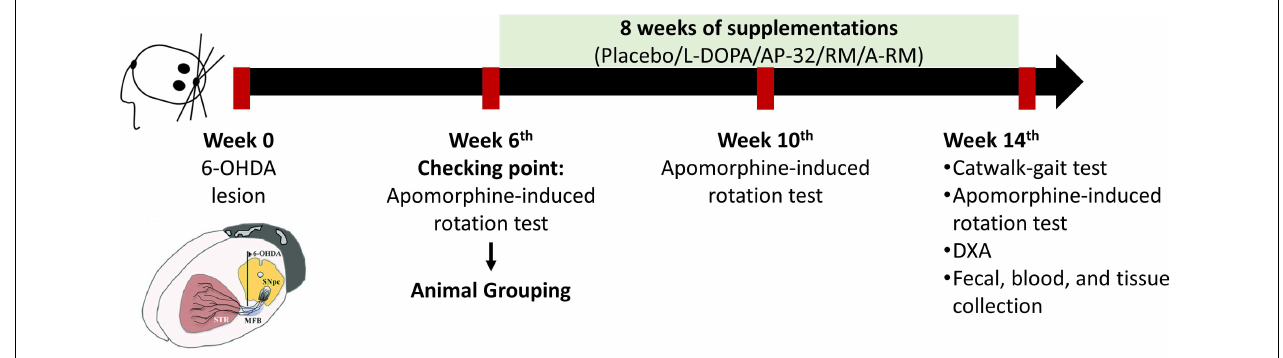
FIGURE 1 | Timeline of the